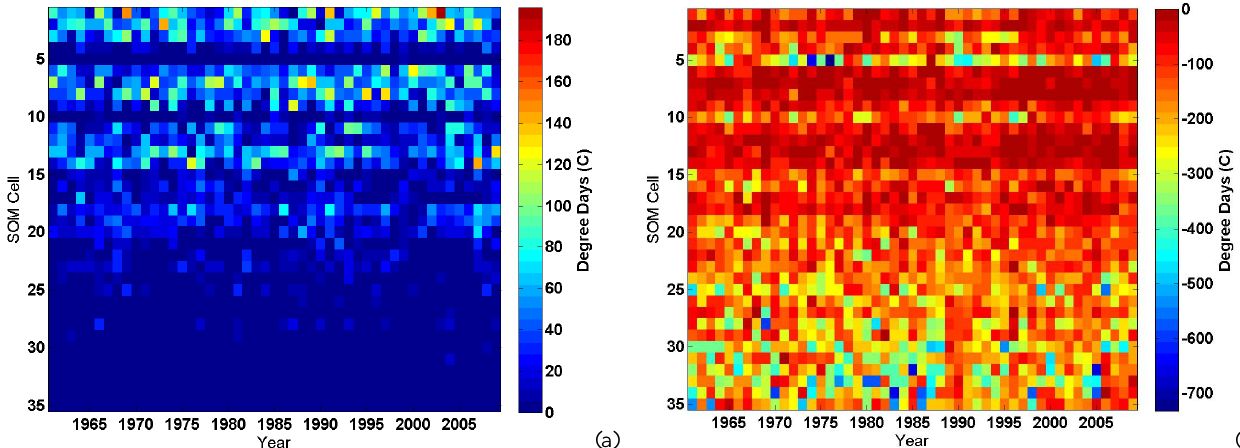
Figure 6a. Positive (A) and negative (B) degree-days by SOM pattern for each year of the NCEP record used here. These plots show which weather patterns most strongly influence freeze or thaw seasons. For example, Patterns 30-35 dominate freezing but have little influence on thawing, and these patterns show high variability indicating they are responsible for much of the inter- annual variability. The plots also show trends. For example, Patterns 11-14 have been getting warmer in the freeze season (more dark reds in Fig. 6B) as well as warmer in the thaw season(less dark blue in Fig. 6A). The causes for individual warm or cold years (Fig. 8) can also be pinned to individual patterns using these plots.